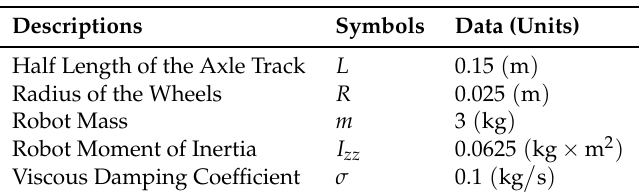
Table 1. Mobile robot